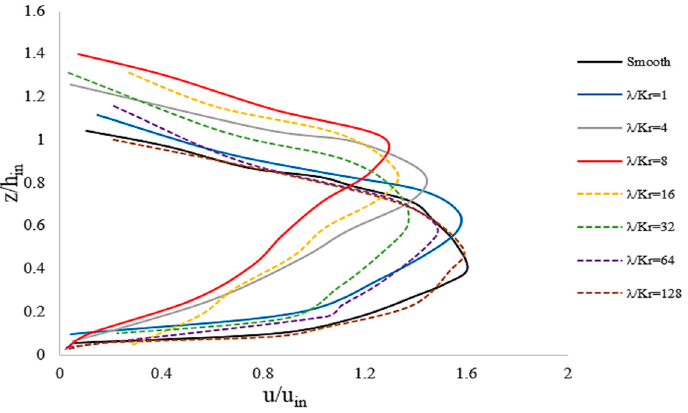
Figure 8. Comparison of velocity profiles for different bed types at X =4 m corresponding to h in = 7 cm, C in = 5 g/L, S = 1.75%, Q in = 1